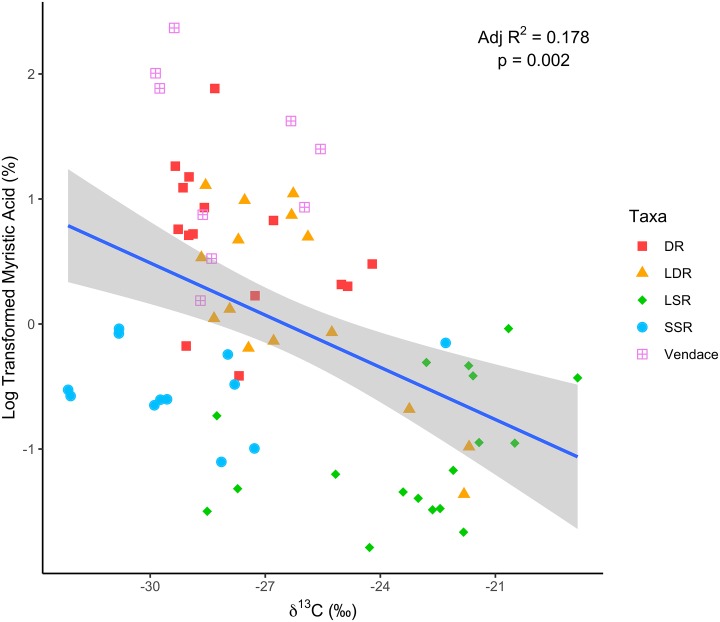
Relationship between log-transformed myristic acid concentration (%) and δ13C (‰) in coregonid taxa.DR = densely-rakered whitefish, LDR = large densely-rakered whitefish, LSR = large sparsely-rakered whitefish, SSR = small sparsely-rakered whitefish.